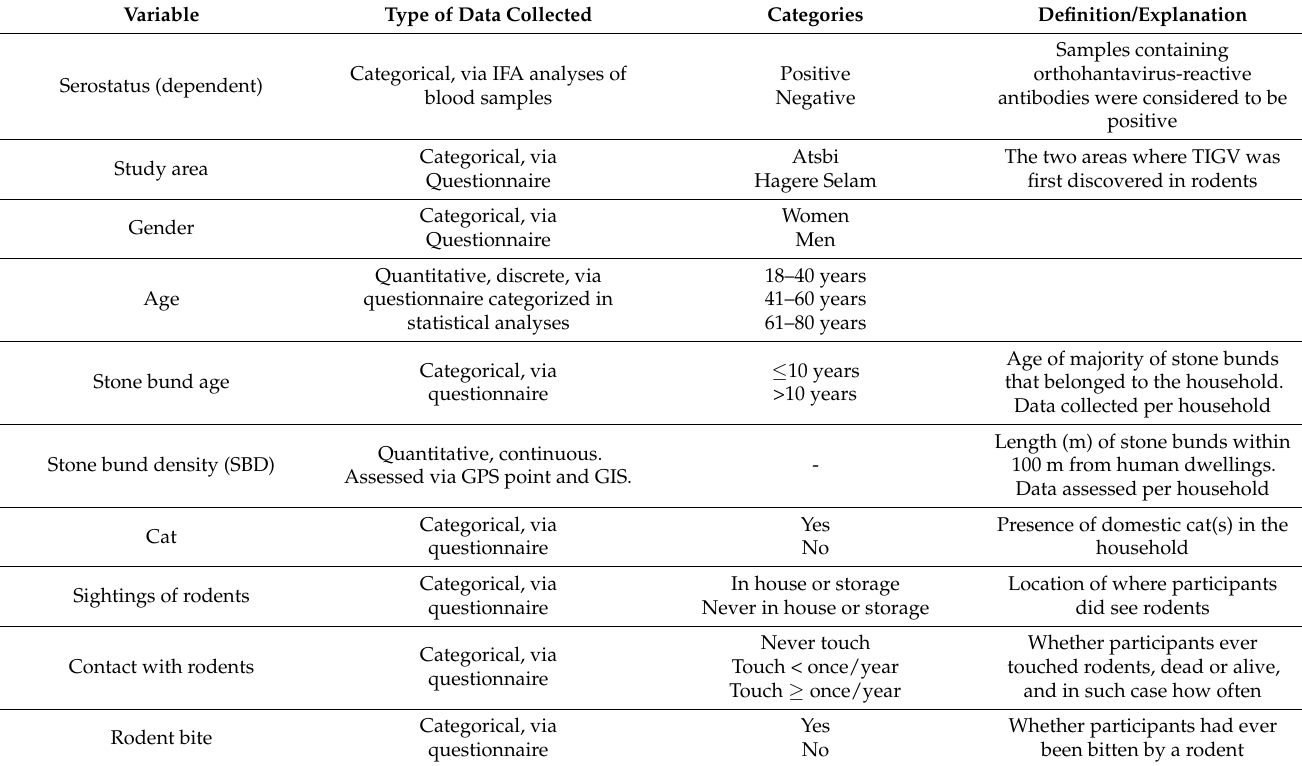
Table 1. Variables used in the statistical